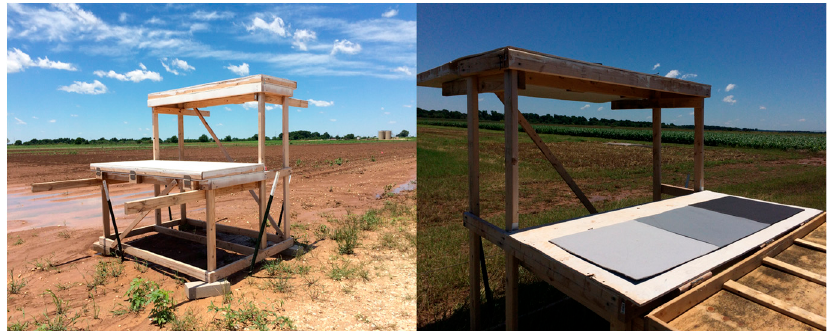
Figure 6. Ground control points set up in the field for geo-referencing, radiometric calibration, and crop height calibration (Photo Credit: Cody Bagnall).